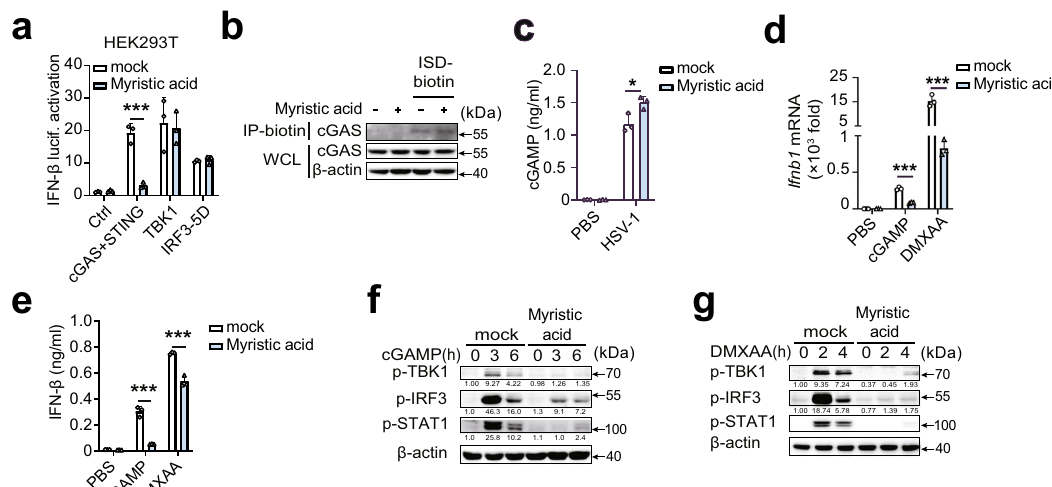
Fig. 3 | Myristic acid inhibits STING activation. a Luciferase activity analysis of HEK293T cellstransiently transfectedwith interferon (IFN)- β reporter plasmidand adapter plasmids as indicated, n =3 samples examined over 3 independent experiments. b Invitropull-downassayanalysisofIFN-stimulatingDNA(ISD)-biotin binding to cGAS. c Enzyme-linked immunosorbent assay (ELISA) analysis of cyclic adenosine monophosphate (AMP) – guanine monophosphate (GMP) (cGAMP) pro- duction in peritoneal macrophages (PMs) treated with solvent (mock) or myristic acid, followed by herpes simplex virus 1 (HSV-1) infection, n =3 samples examined over 3 independent experiments. d – g Quantitative polymerase chain reaction